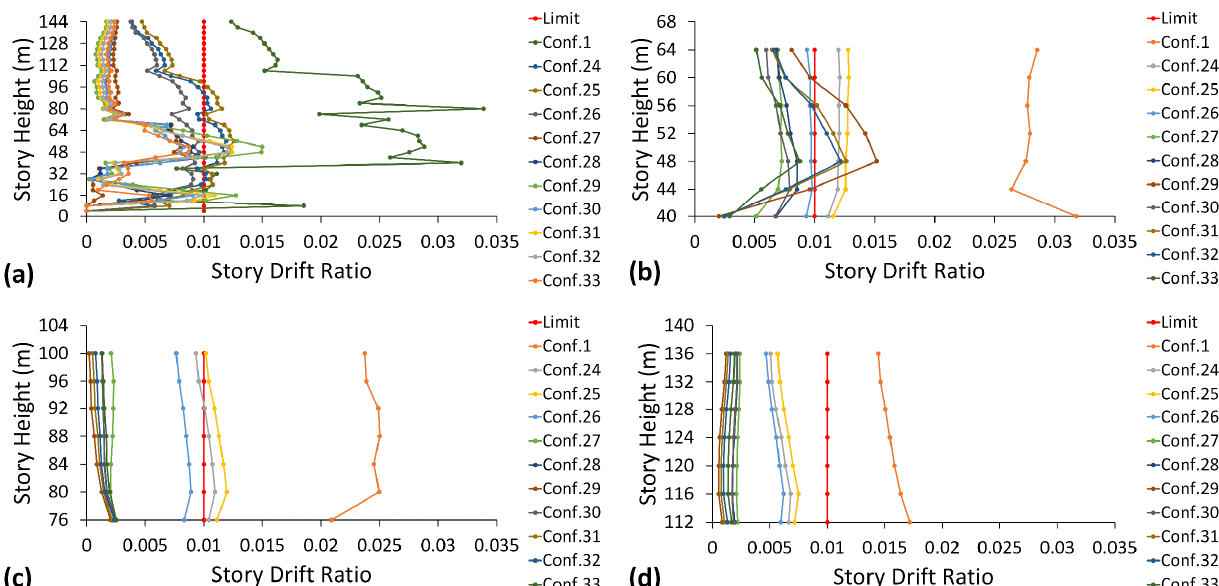
Figure 12. Residual story drift of different configurations under the Nahanni earthquake: ( a ) mega- frame, ( b ) first substructure, ( c ) second substructure, and ( d ) third substructure.